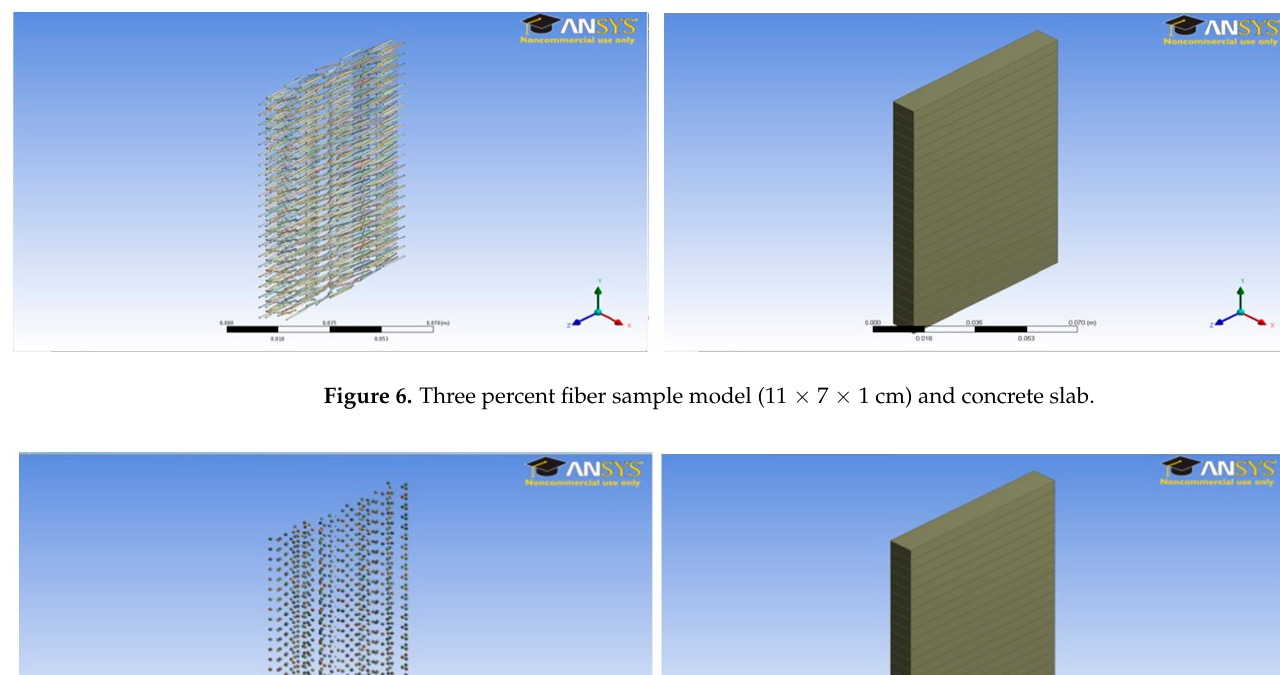
Figure 5. Two percent fiber sample model (11 × 7 × 1 cm) and concrete slab.